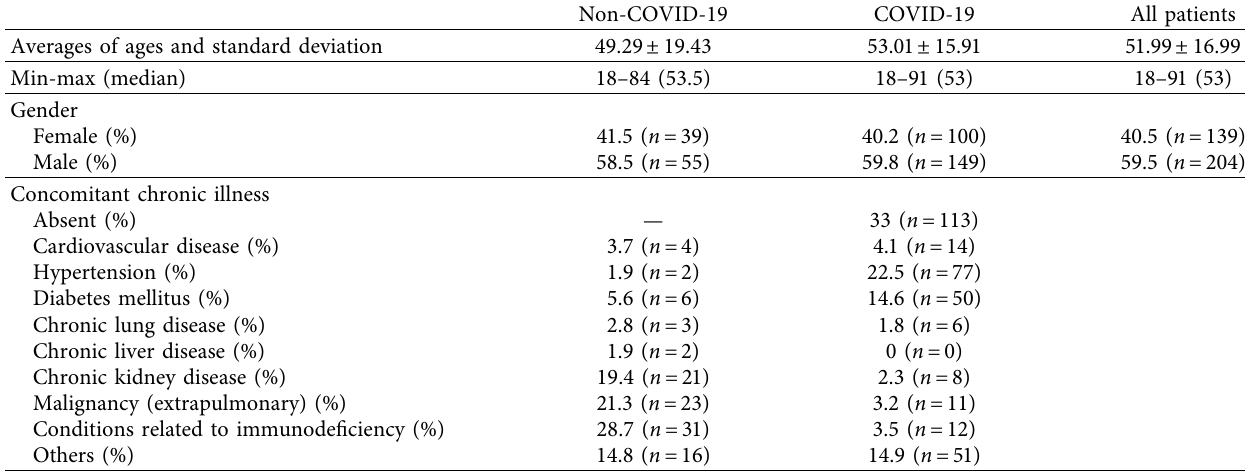
Table 1: Distribution of patients according to age, gender, and concomitant diseases.